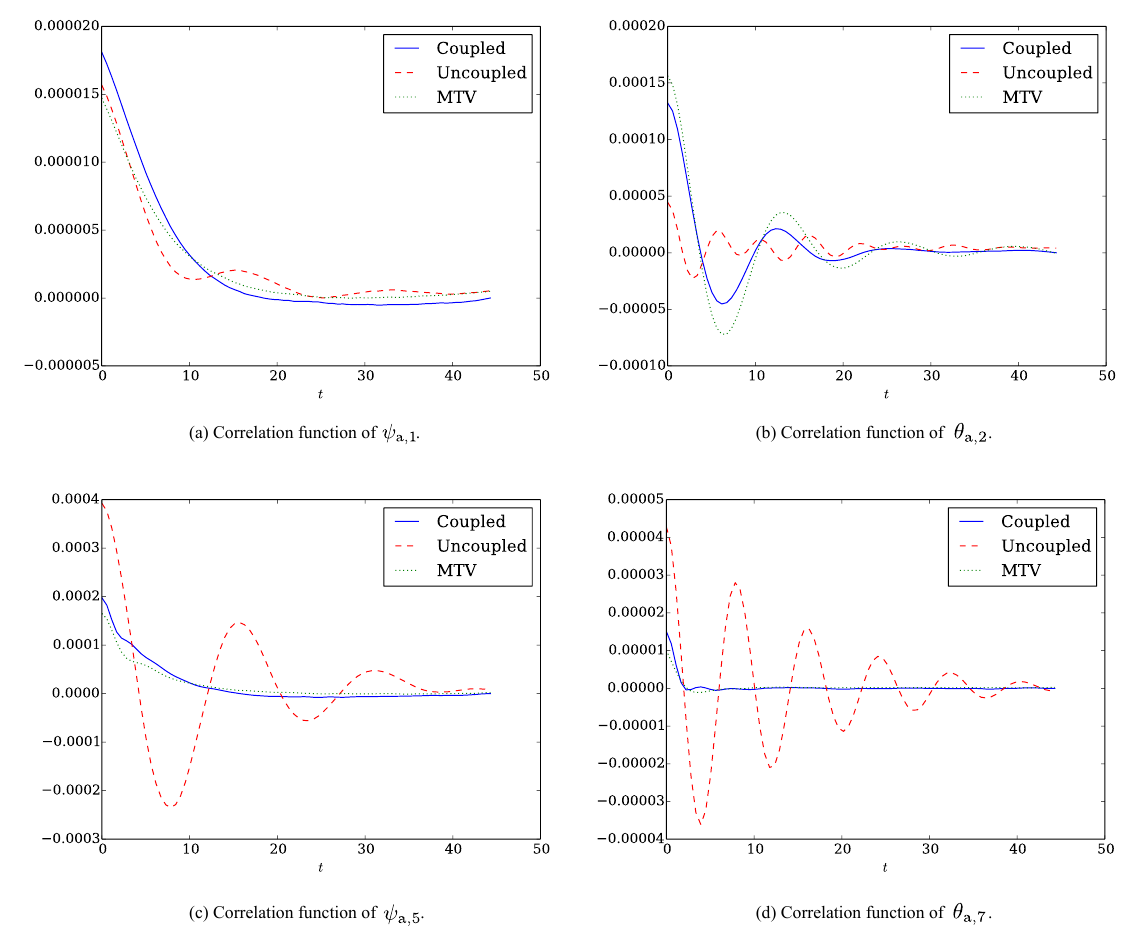
Figure 6. Correlation function of various variables for the wavenumber 2 parameterization and with the parameter set noLFV. The correlation of the full coupled system (13), the uncoupled system and the MTV parameterizations are depicted as a function of the time lag t (in days). The WL parameterization results are not shown as it is unstable and diverges. Table 3. Component averaged Kullback–Leibler divergence with respect to the distributions of the full coupled system, in the case of the wavenumber 2 atmospheric baroclinic variables’